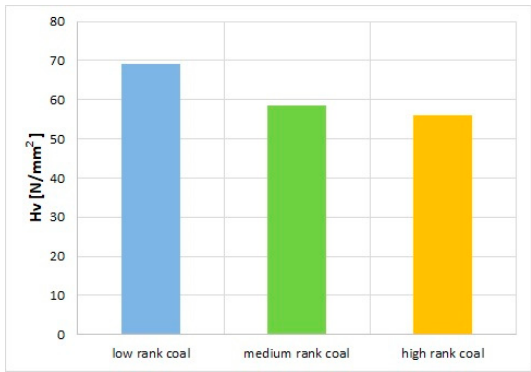
Figure 5. Average micro-hardness values for samples with different metamorphism degree.